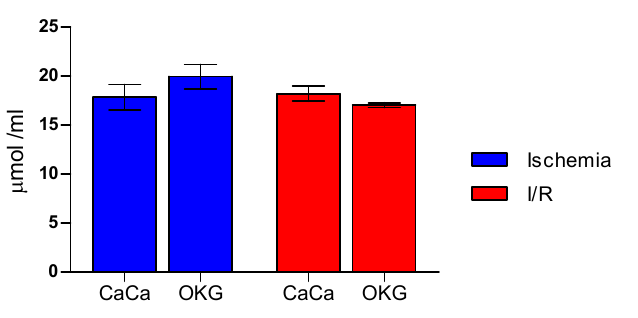
FIGURE 5 - Reduced glutathione levels (micromoles per liter) in plasma samples from CaCa and OKG-pretreated rats. Bars represent mean±SD of ischemia (blue bars) and reperfusion (red bars) groups at the end of the ischemia (30 min) and reperfusion (30 min). GSH levels in OKG treated rats are not different from CaCa-treated rats by Student´s t test.